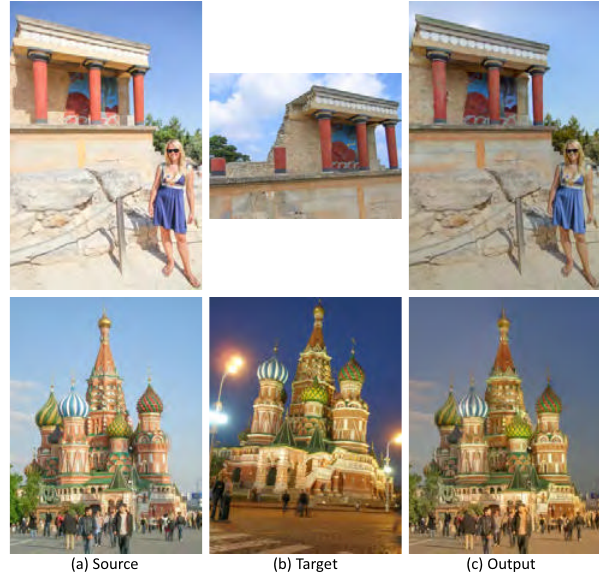
Fig. 9 Image relighting with people present in the landmark photos. Our method produces plausible results for scenes with strong local lighting. The background scene has proper local lighting transferred from the target, and people have a similar color to the